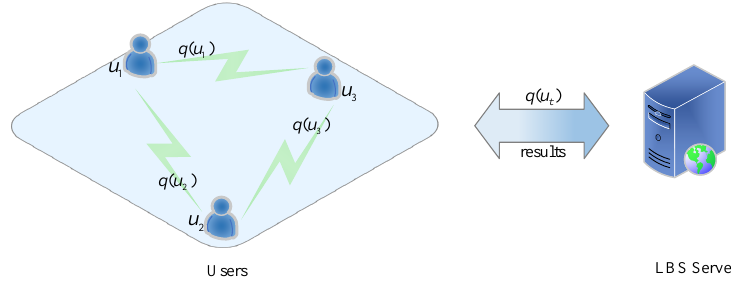
Figure 4. The architecture without a third